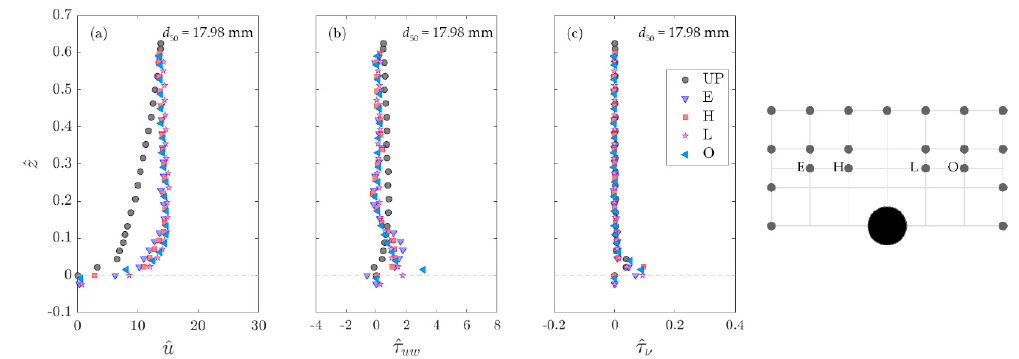
Figure 13. Vertical distributions of ( a ) dimensionless time-averaged velocity, ( b ) dimensionless Reynolds shear stress, and ( c ) dimensionless viscous shear stress measured at y = 0.5 B s in Run 3.